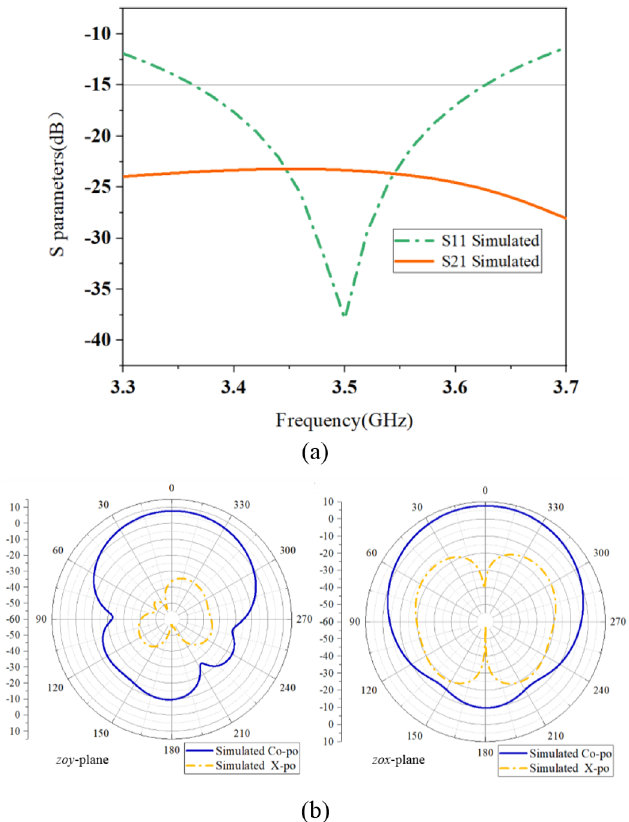
Fig. 2. (a) Simulated S11 and S21 of the dual polarized dipole element, (b) simulated radiation pattern at 3.5GHz in zoy -plane and zox